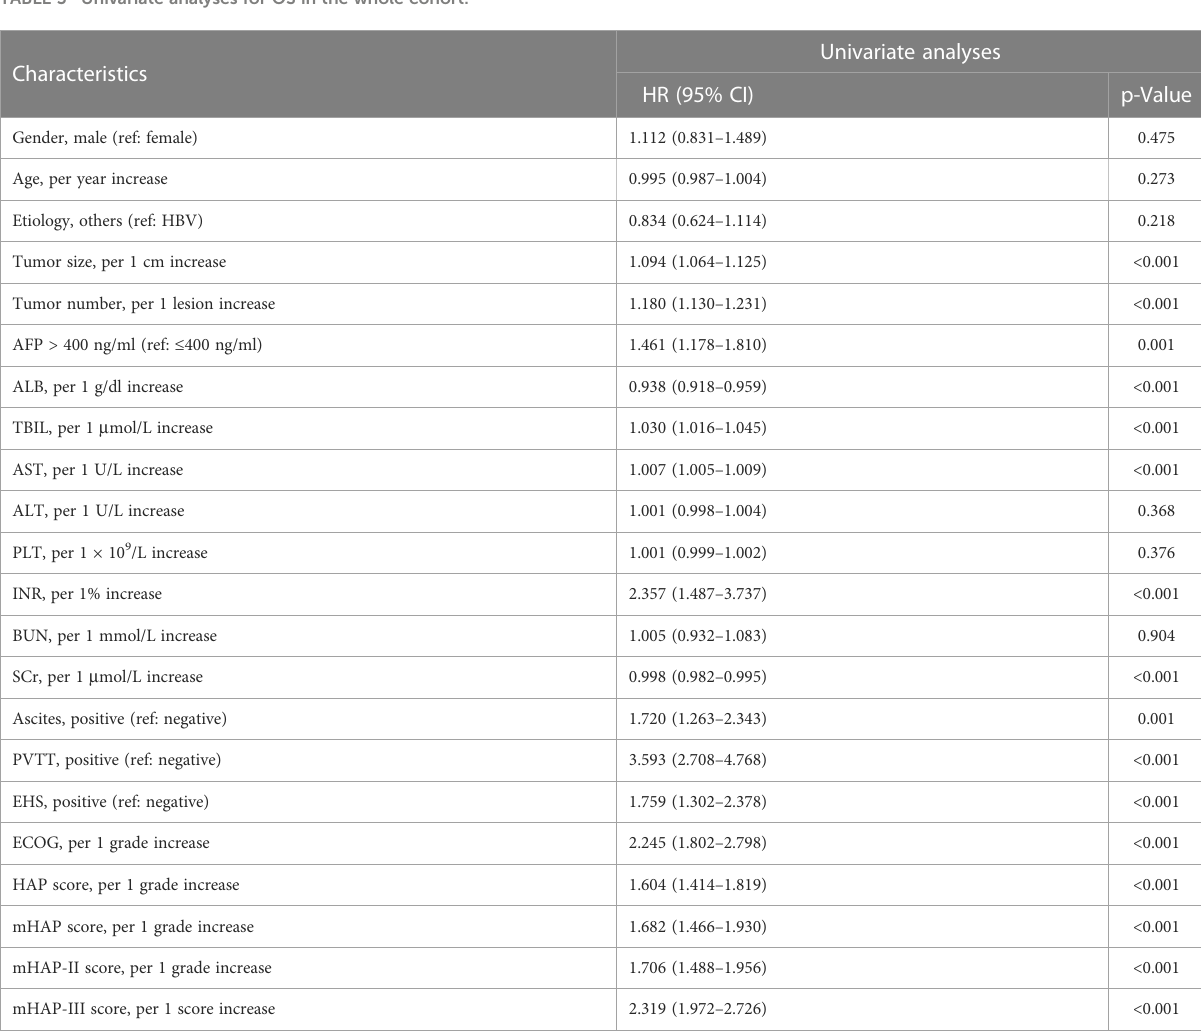
TABLE 3 Univariate analyses for OS in the whole